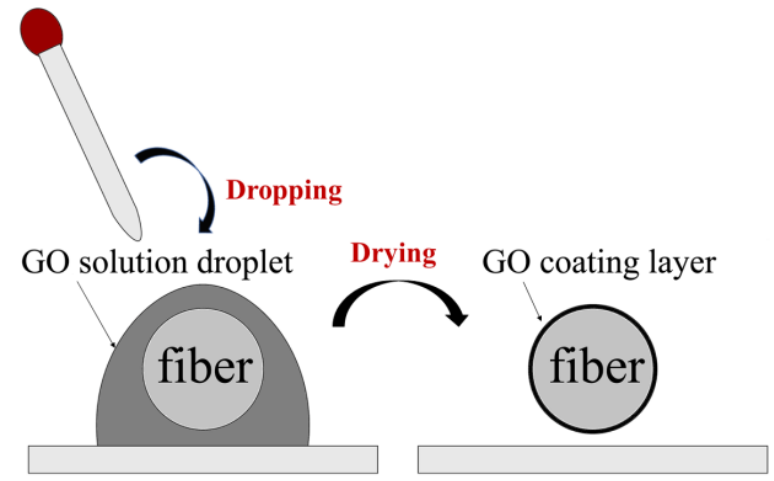
Figure 4. Schematic of coating graphene oxide onto the fiber.